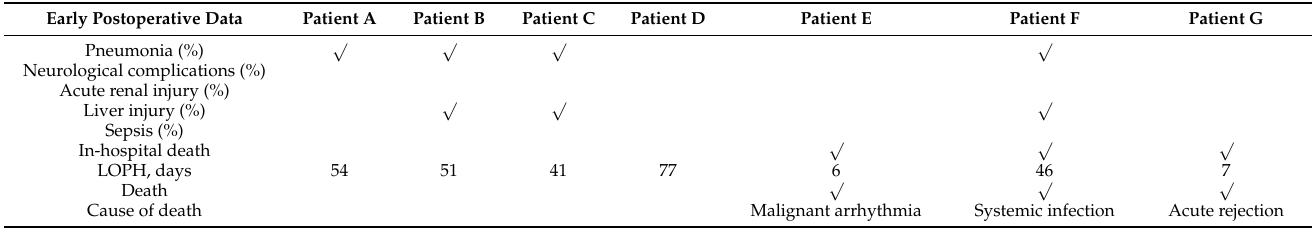
Table 5. Detailed outcomes of recipients with a DRWR > 200% after heart